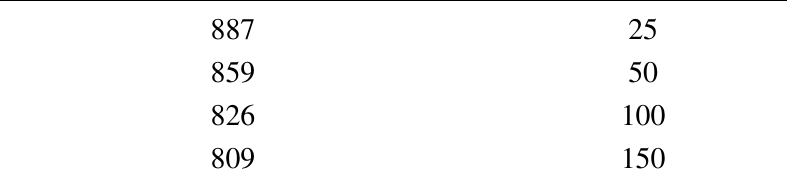
Table 3. Calibration data used to fit finger bending sensor values to spherical